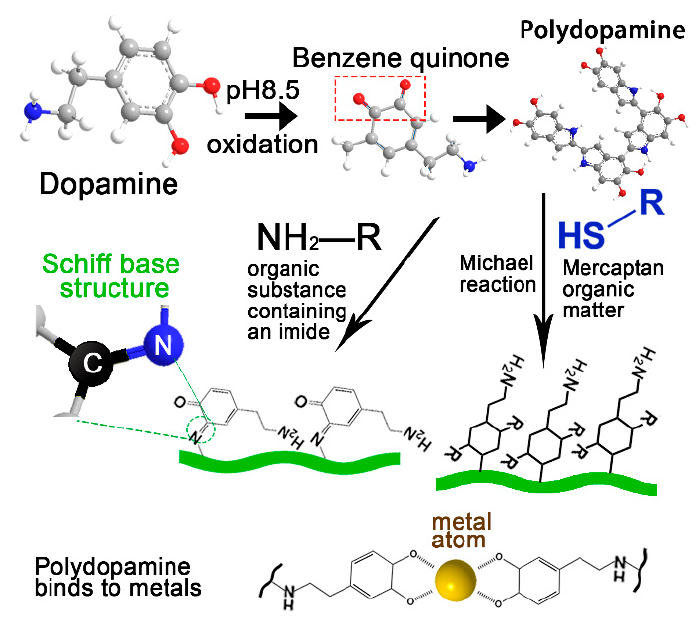
Figure 1. PDA complex